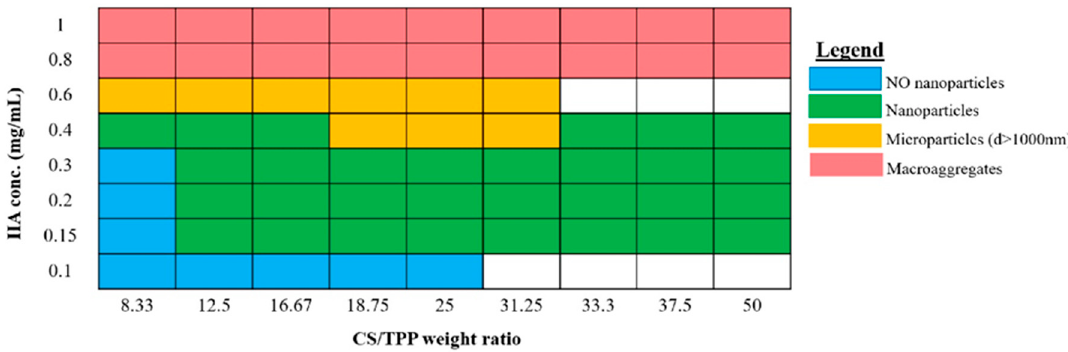
Figure A1. Graphic representation of experimental design space (blank square means “not